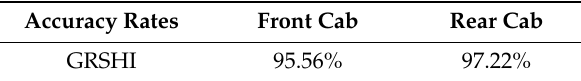
Table 10. Accuracy rates at each